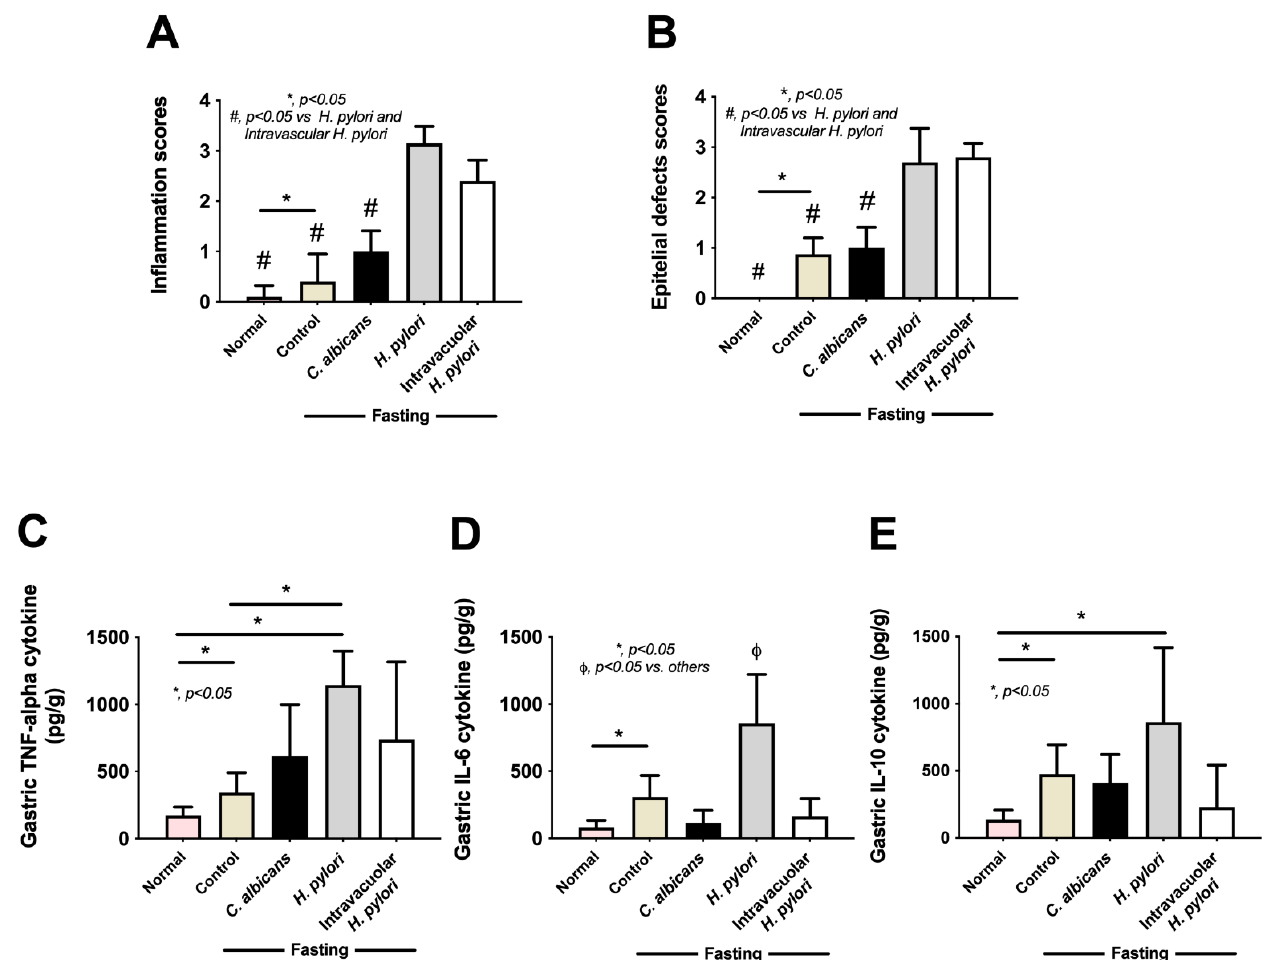
Figure 6. Representative pictures of histological scores; inflammatory and epithelial defects in mice stomachs ( A , B ) at 12 weeks after fasting and the administration of H. pylori , C. albicans (control), or Candida containing intravacuolar H. pylori are demonstrated by histological scores ( A , B ) and levels of gastric cytokines (IL-6, TNF- α , and IL-10) ( C – E ) (n = 10/group). *, p < 0.05; #, p < 0.05 vs. H. pylori control and intravacuolar H. pylori groups; ϕ , p < 0.05 vs. others, as calculated by ANOVA with Tukey’s analysis.